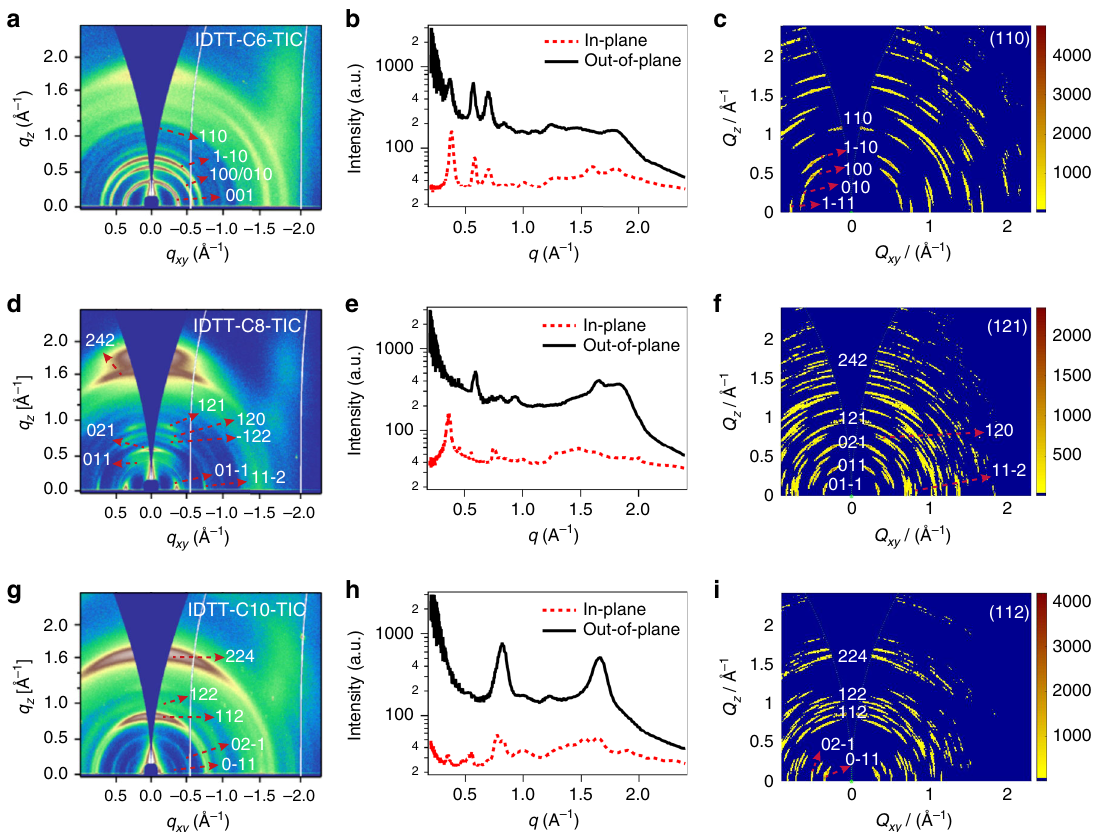
Fig. 2 GIWAXS and simulated data. a , d , g GIWAXS diffraction patterns of IDTT-CX-TIC neat fi lms and ( b , e , h ) the corresponding in-plane and out-of- plane line-cut pro fi les. c , f , i The simulated results of IDTT-CX-TIC unit cells. The major molecular packing peaks with the detailed peak labeling was translated from single crystal to thin fi lm. It can be seen that the major diffraction peaks of IDTT-CX-TIC fi lms can be well traced from single-crystal unit